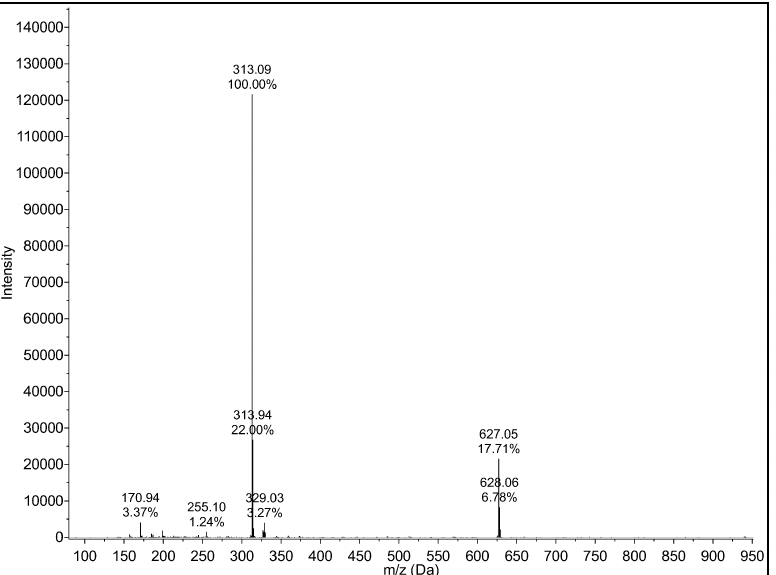
Figure A2. Mass spectrum of cannabidiol (CBD) recorded by ESI-MS in negative mode. The spectrum shows the molecular signal of CBD at m/z = 313.09 (exact mass of CBD = 314.46g/mol).